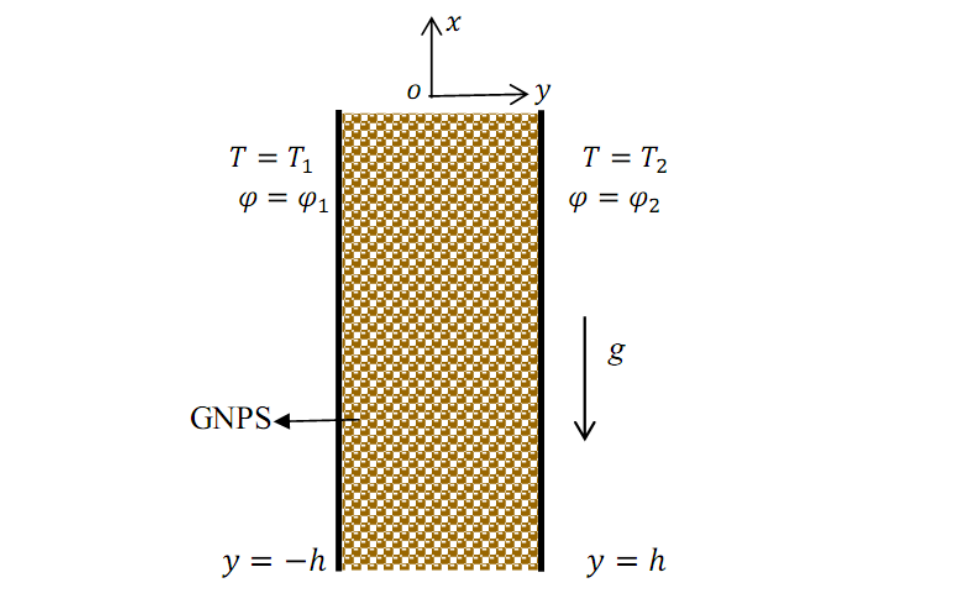
Figure 1. Physical model and coordinate system.